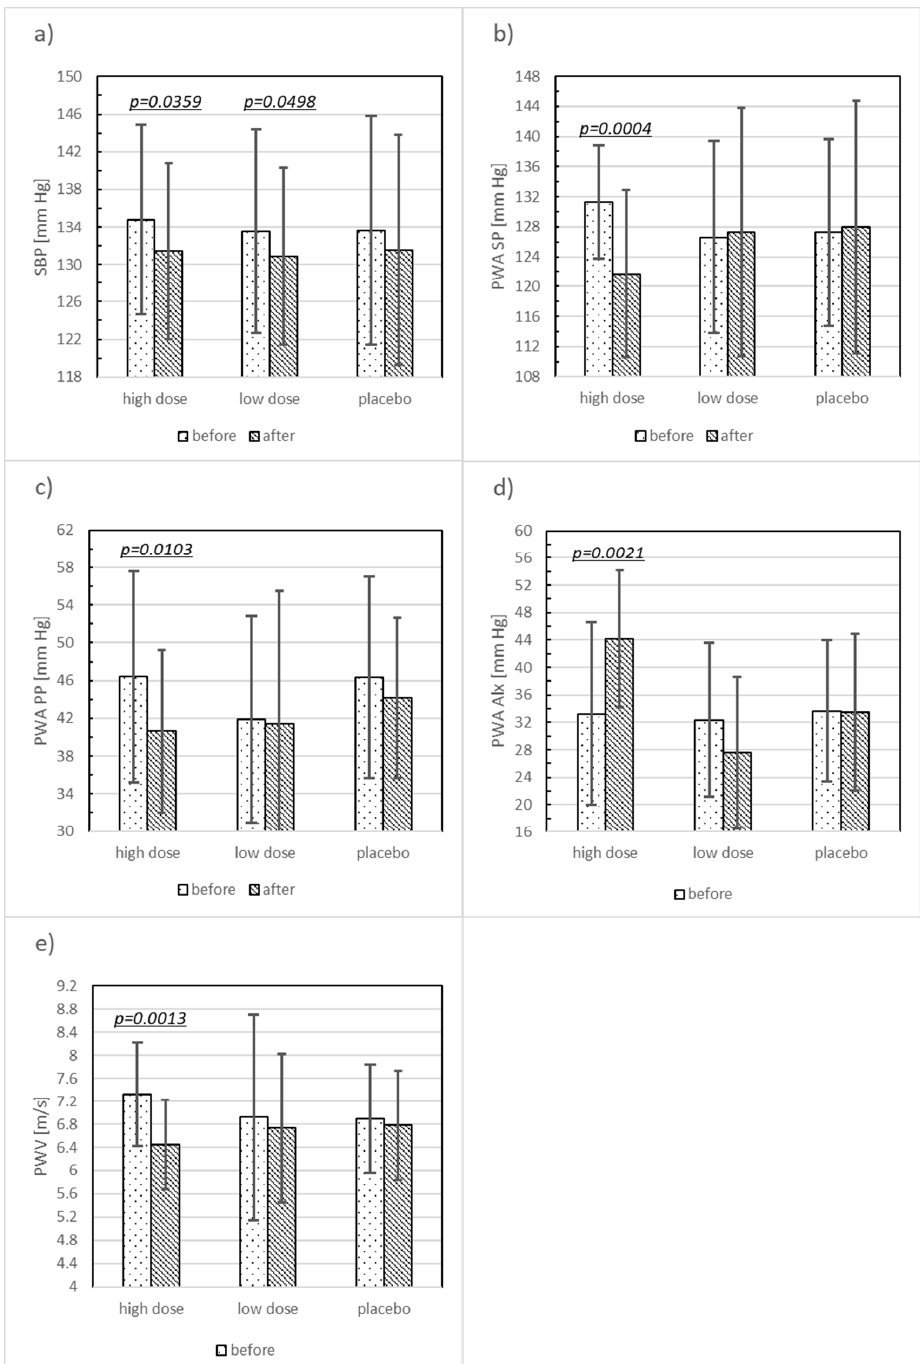
Figure 2. The comparison of the functional parameters in the high dose (HD), low dose (LD), and placebo groups at the beginning of the study and after three months of probiotic supplementation. Significant differences are highlighted showing the p -value. Data are the arithmetic mean ± SD; ( a ) SBP: systolic blood pressure; ( b ) PWA SP: pulse wave analysis systolic pressure; ( c ) PWV: pulse wave velocity; ( d ) PWA Alx: pulse wave analysis augmentation index; ( e ) PVV: pulse wave velocity.